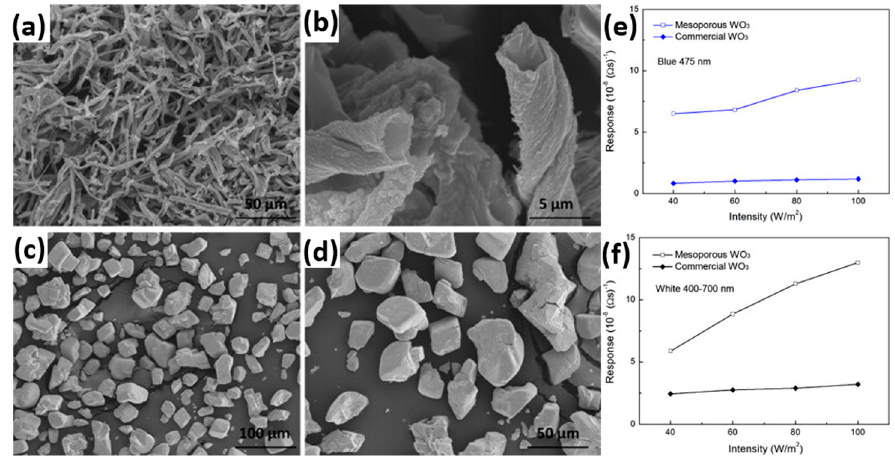
Figure 42. SEM images of ordered mesoporous In 2 O 3 with large particles ( a ) and small particles ( b ); Dynamic response and recovery to O 3 at room temperature with blue LED illumination of the large particles ( c ) and small particle layer ( d ); Schemes ( e , f ) explaining the difference in the base line resistance for the two sensing layers. Reproduced with permission from [69].